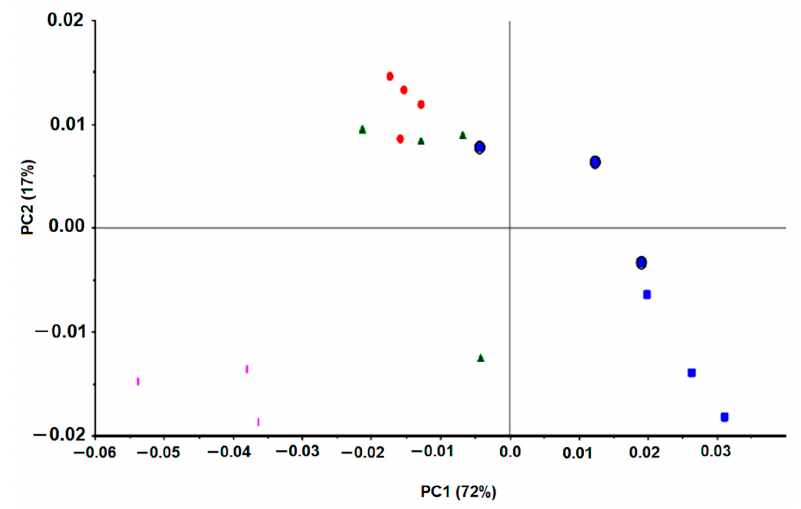
Figure 7. PCA of first derivative spectra of J99 H. pylori incubated with different clarithromycin concentrations: Blue square, 0 mg/L; Blue circle, 1.5 to 7.5 mg/L; Red, 15 mg/L (MIC); Green, 30 mg/L; concentrations: Blue square, 0 mg / L; Blue circle, 1.5 to 7.5 mg / L; Red, 15 mg / L (MIC); Green, 30 mg / L; Pink, 75 mg/L. Pink, 75 mg /